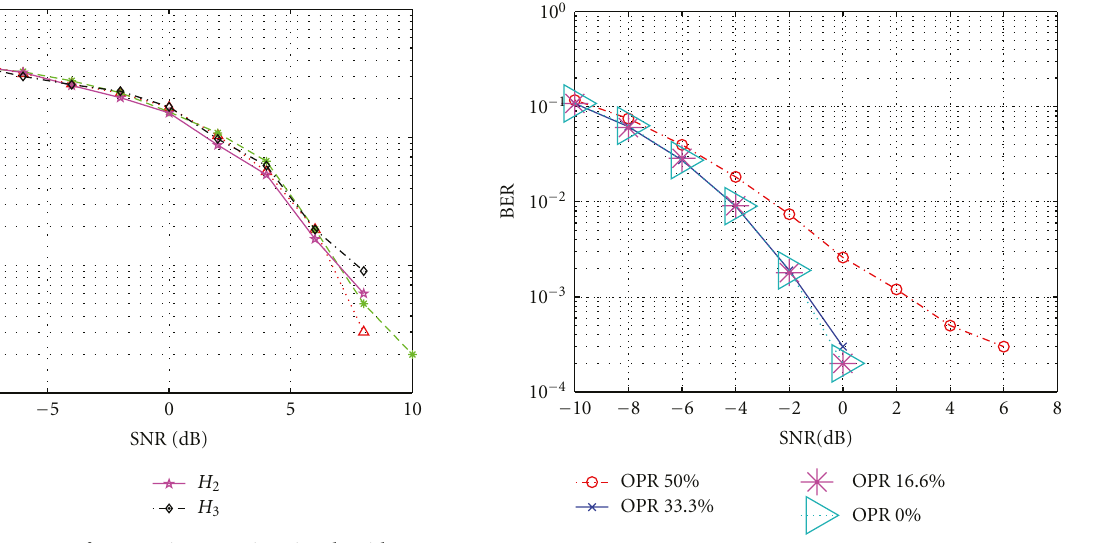
Figure 7: BER versus SNR with di ff erent time shifts.